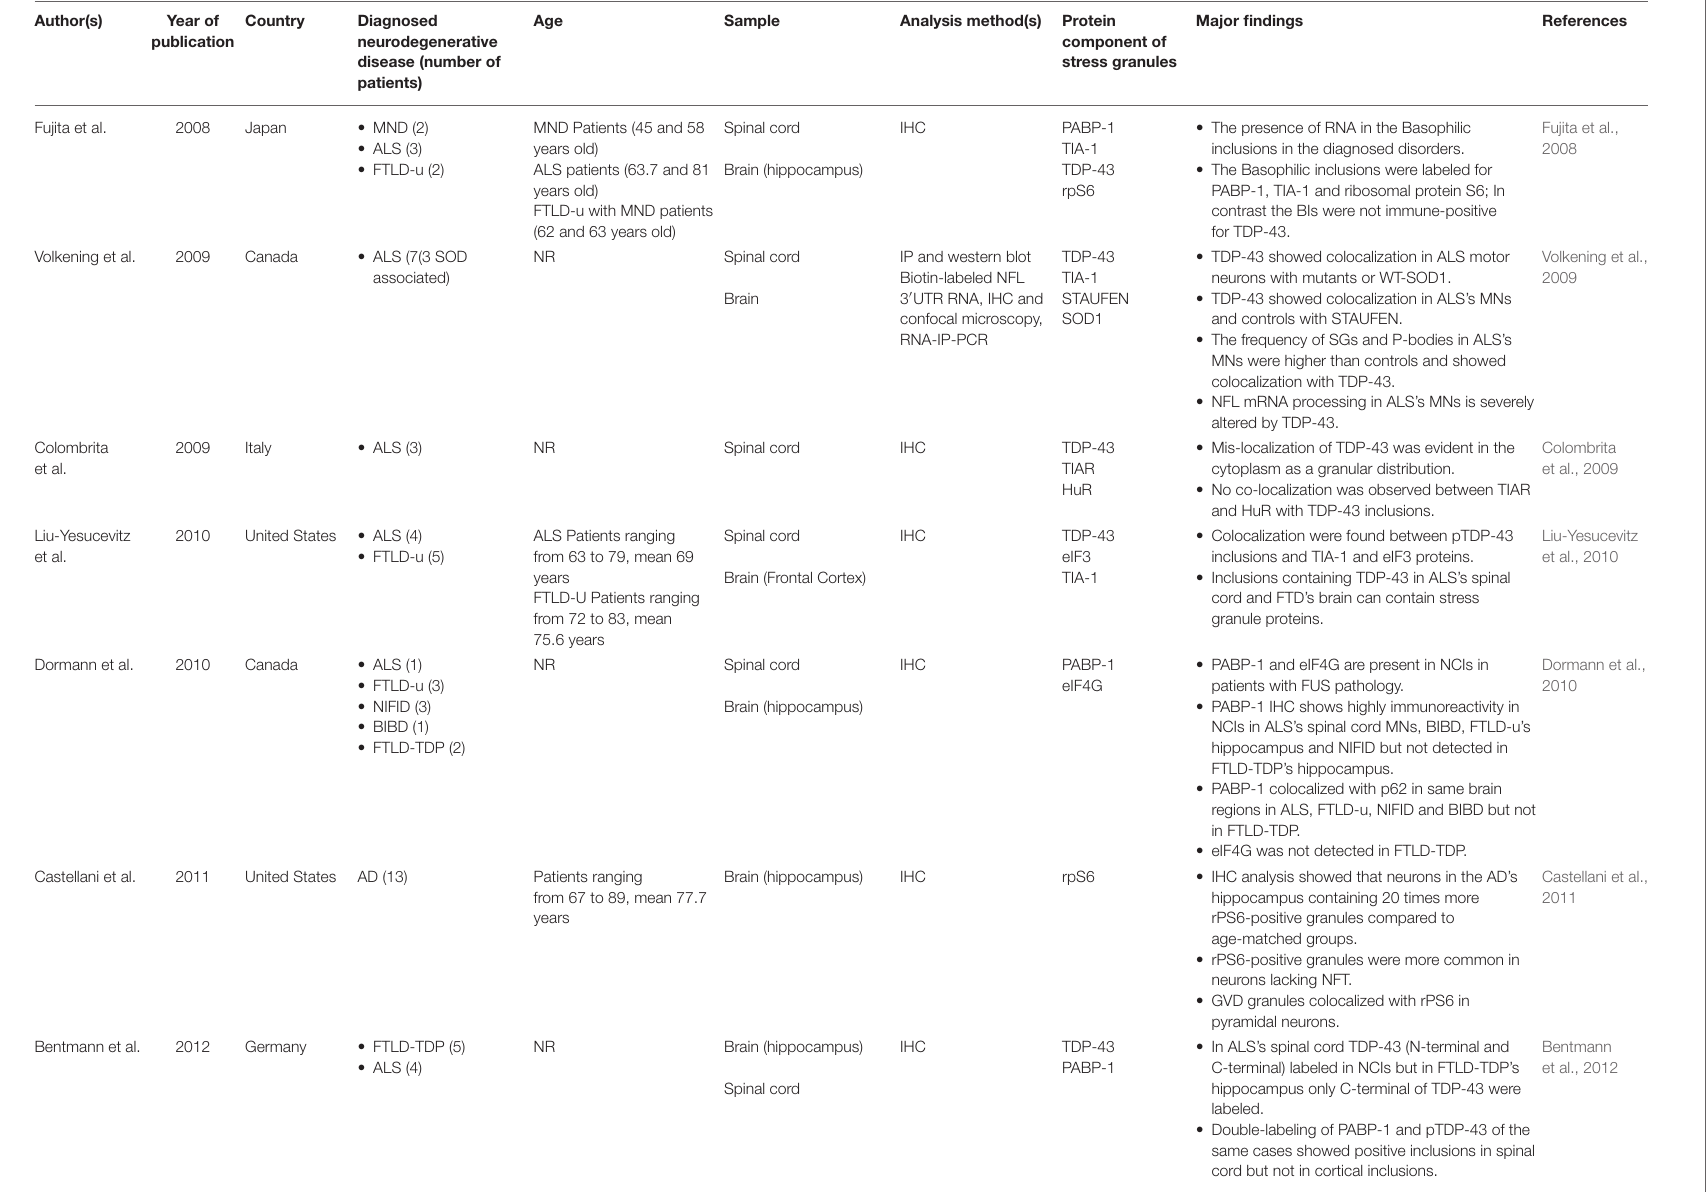
TABLE 2 | Stress Granules and neurodegenerative disorders in human samples.